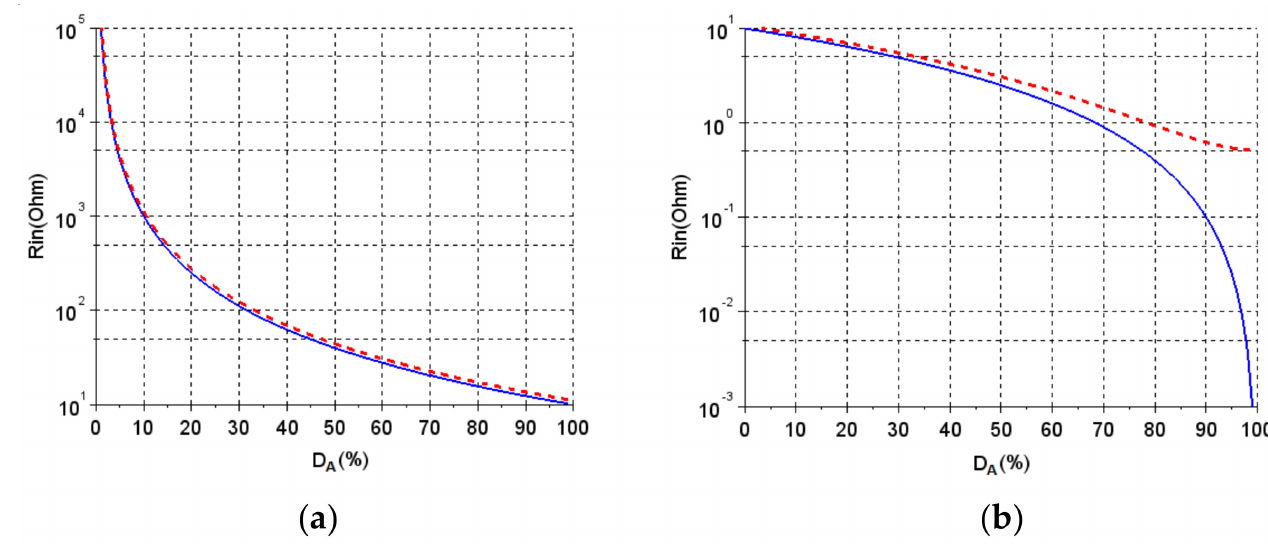
Figure 4. Input resistance of the ( a ) buck and ( b ) boost converters as a function of the duty cycle. The solid line is the ideal model, and the dashed line is the model with parasitic